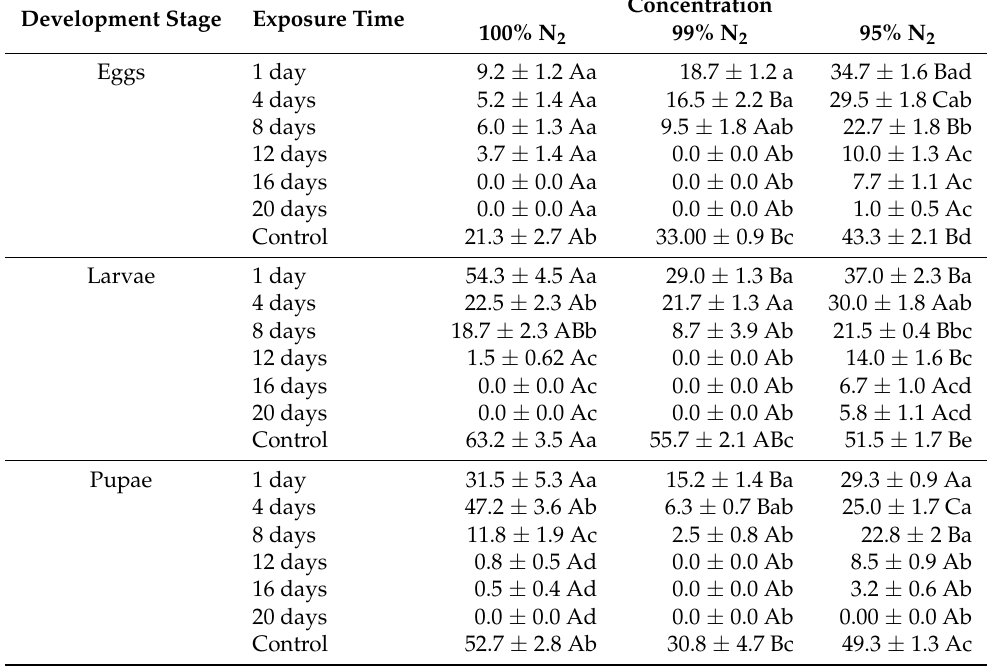
Table 5. Laboratory efficacy (Average No. of adults emerged following their treatment in subadult stages; Av. No. ± SE) as of six exposure times (ranging from 1 to 20 days) and three concentrations (ranging from 95% to 100% N 2 ) nitrogen-based controlled atmospheres on eggs, larvae of adzuki bean weevil ( Callosobruchus chinensis ). (Different letters indicate statistically significant differences between